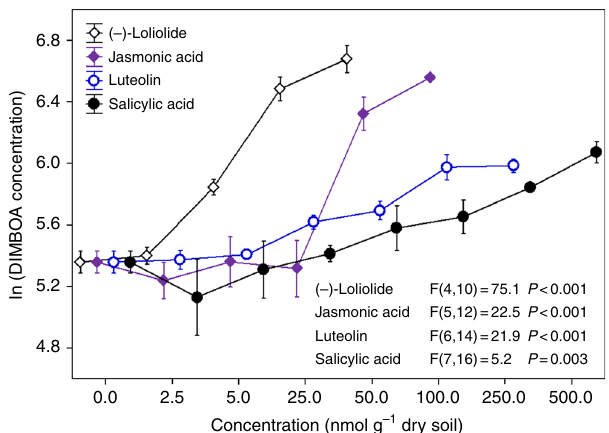
Fig. 4 Induced effect of four potential signaling chemicals at diferent doses on the production of DIMBOA in wheat roots. The effect of concentration levels of the four potential signaling chemicals on the concentration of allelochemical DIMBOA was tested using linear model with chemical concentration as a fi xed factor. Log e -transformed allelochemical DIMBOA were used as response variables. Values plotted are means ( n = 3) ± standard errors (SE). The error bar denotes 1